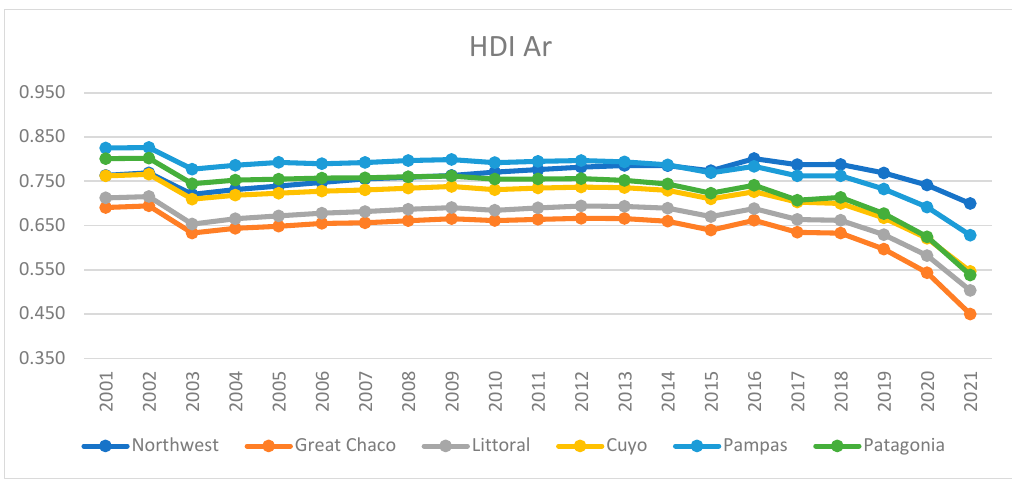
Figure 2. HDI evolution Argentina. Source: United Nations.